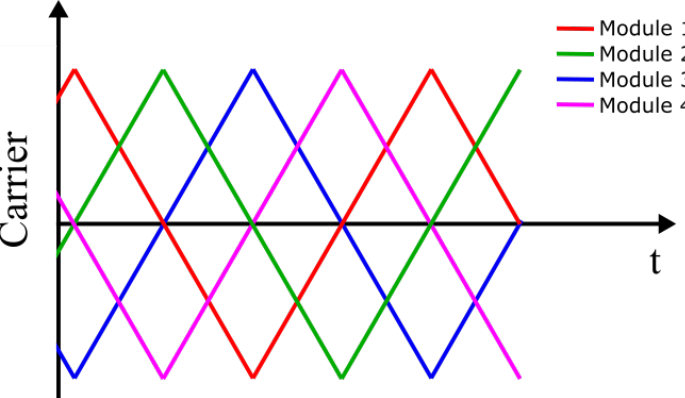
Figure 38. Interleaved carrier signals: phase shift of 90 ◦ for four module